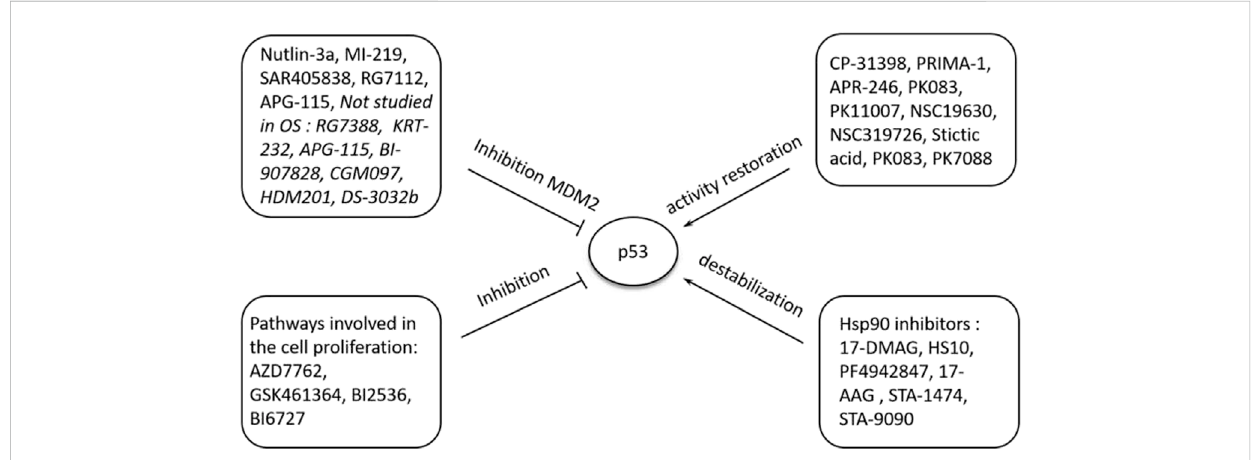
FIGURE 1 A summary ofthe regulation and occurrence of ferroptosis inosteosarcoma. A four-foldmanifestation of p53 shows how osteosarcomaoutcomes unfolds: inhibition, destabilization, activity restoration and inhibition via MDM2. Each of these pathways down- and up-regulate p53 ’ s inhibitory and excitatory functions in osteosarcoma